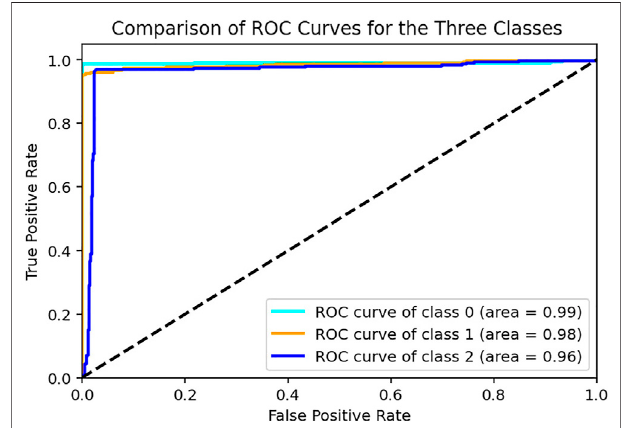
FIGURE 7 | ROC curves for the three tasks obtained using all the test sets when model is trained with Real Data + 110% generated data for training